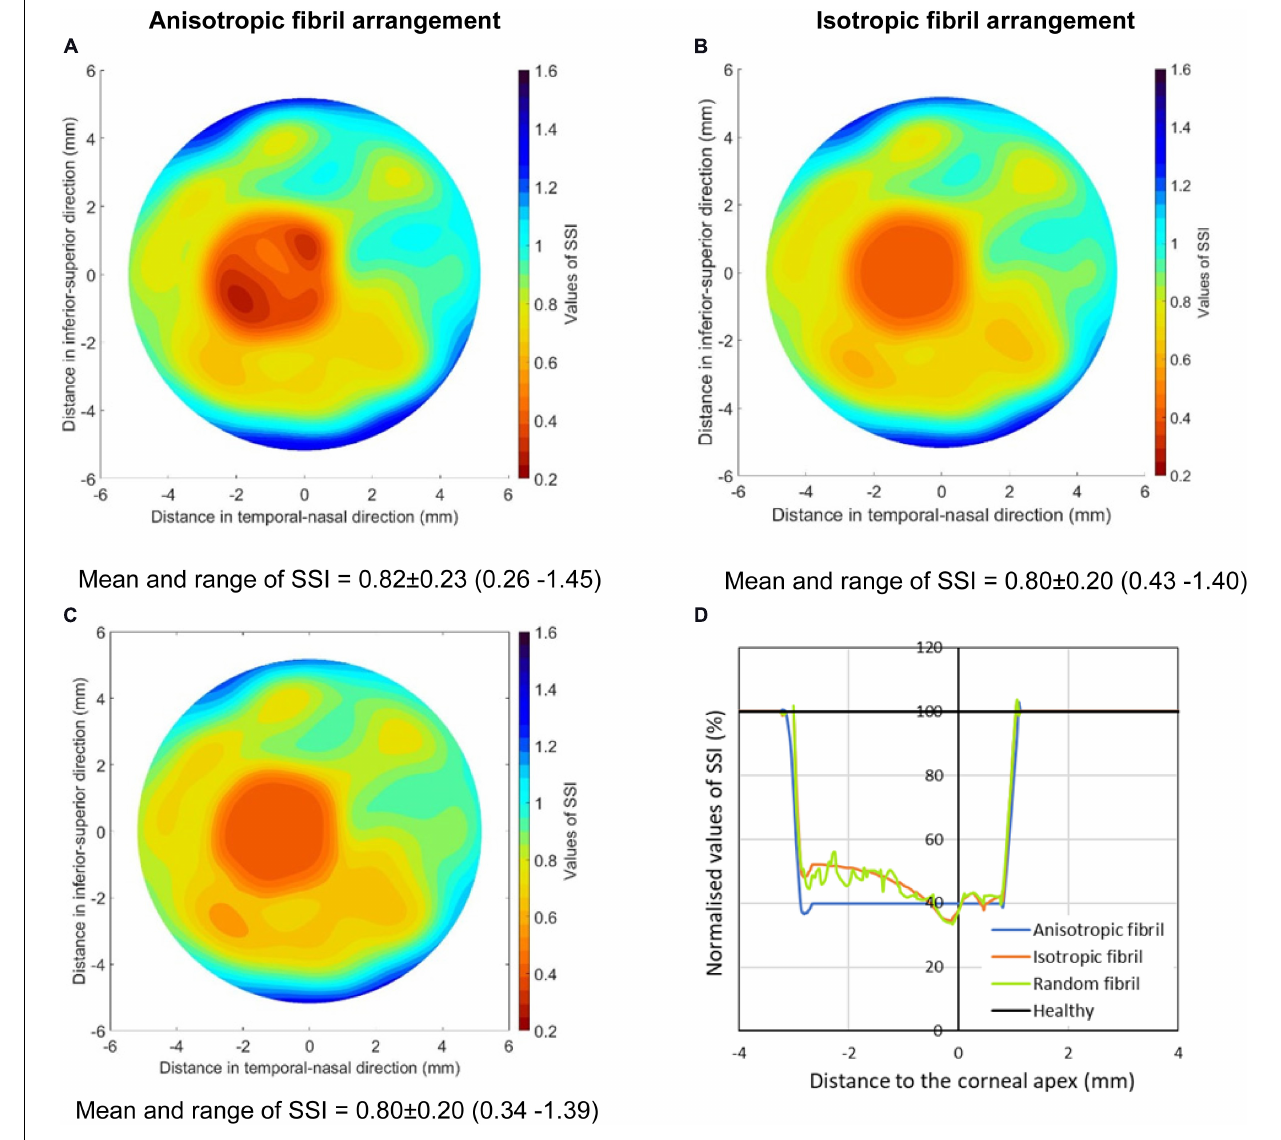
FIGURE 6 | SSI maps of three KC cases including (A) a model with the same fibril arrangement as in healthy tissue but with 60% fibril reduction in the cone, (B) a model with uniform and isotropic fibril distribution in the cone, and (C) a model in which the variation of fibril density from point to point within the cone, as well as the anisotropy at each point, was made random. All three models had the same total fibril content within the cones. (D) presents normalized SSI values along the horizontal central meridian of the cornea for all three